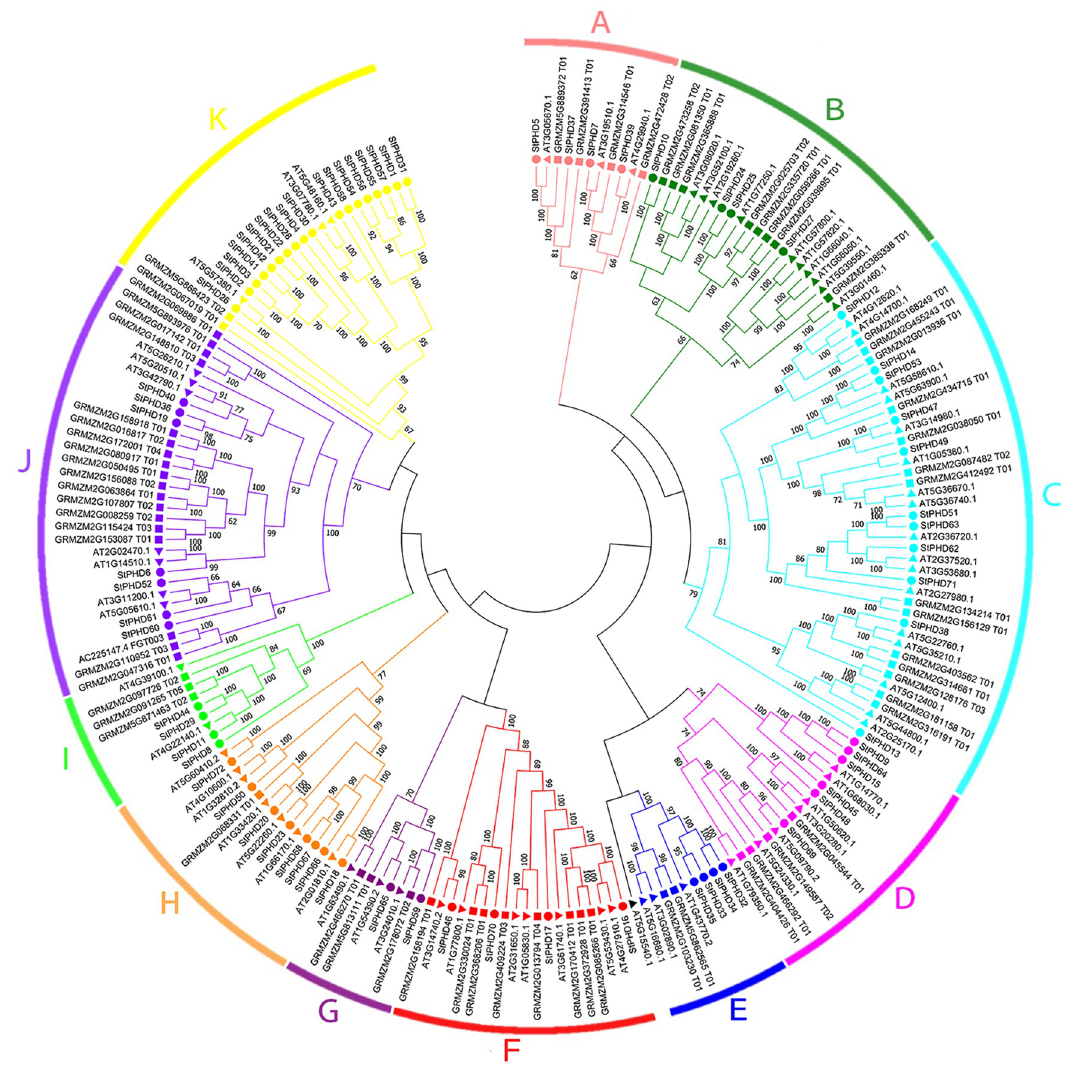
Fig 4. Phylogenetic analysis of potato, Arabidopsis and maize PHDs. The tree was constructed by maximum-likelihood method. Each PHD subfamily was marked by a specific color, except for black, which represented genes that did not belong to any subfamily due to low bootstrap values. The square, circle and diamond represent maize, potato and Arabidopsis PHD proteins,